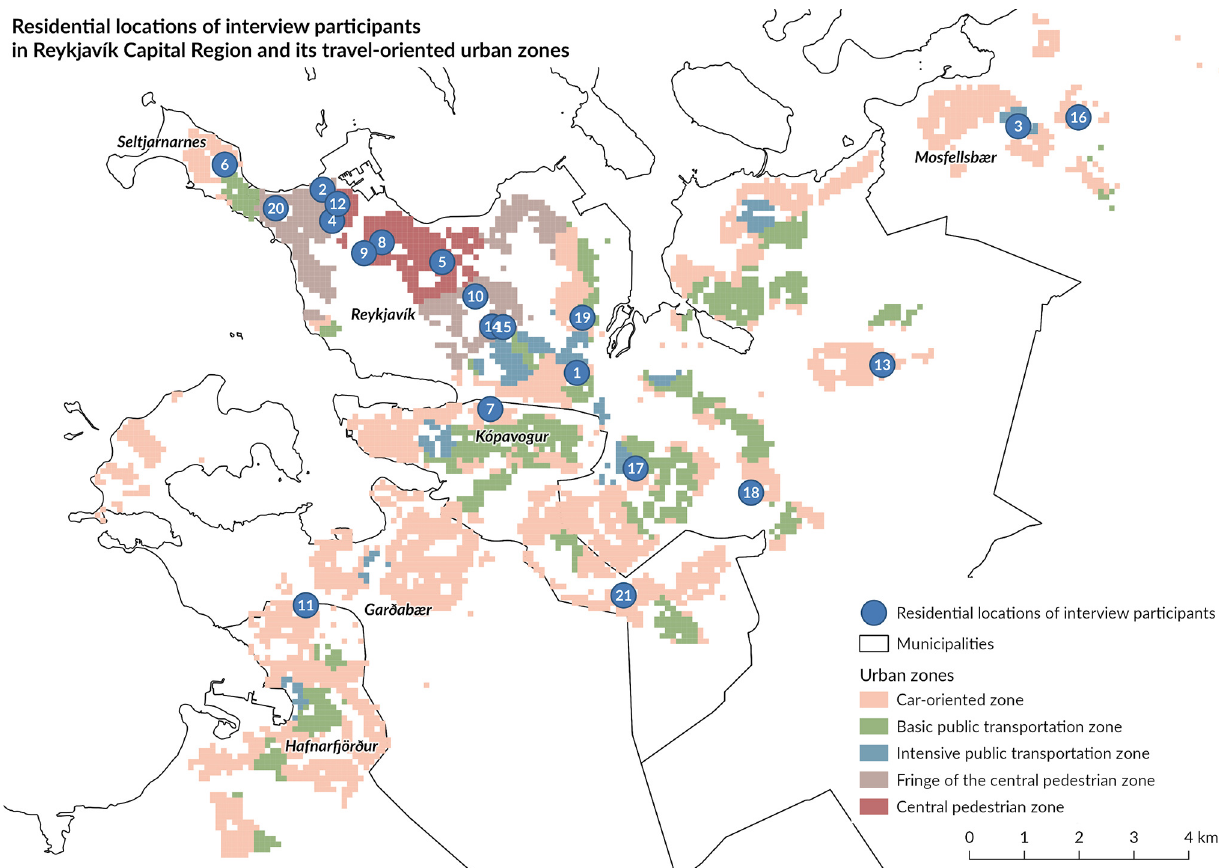
Figure 1. Residential locations of interview participants in Reykjavik Capital Region and its travel‐oriented urban